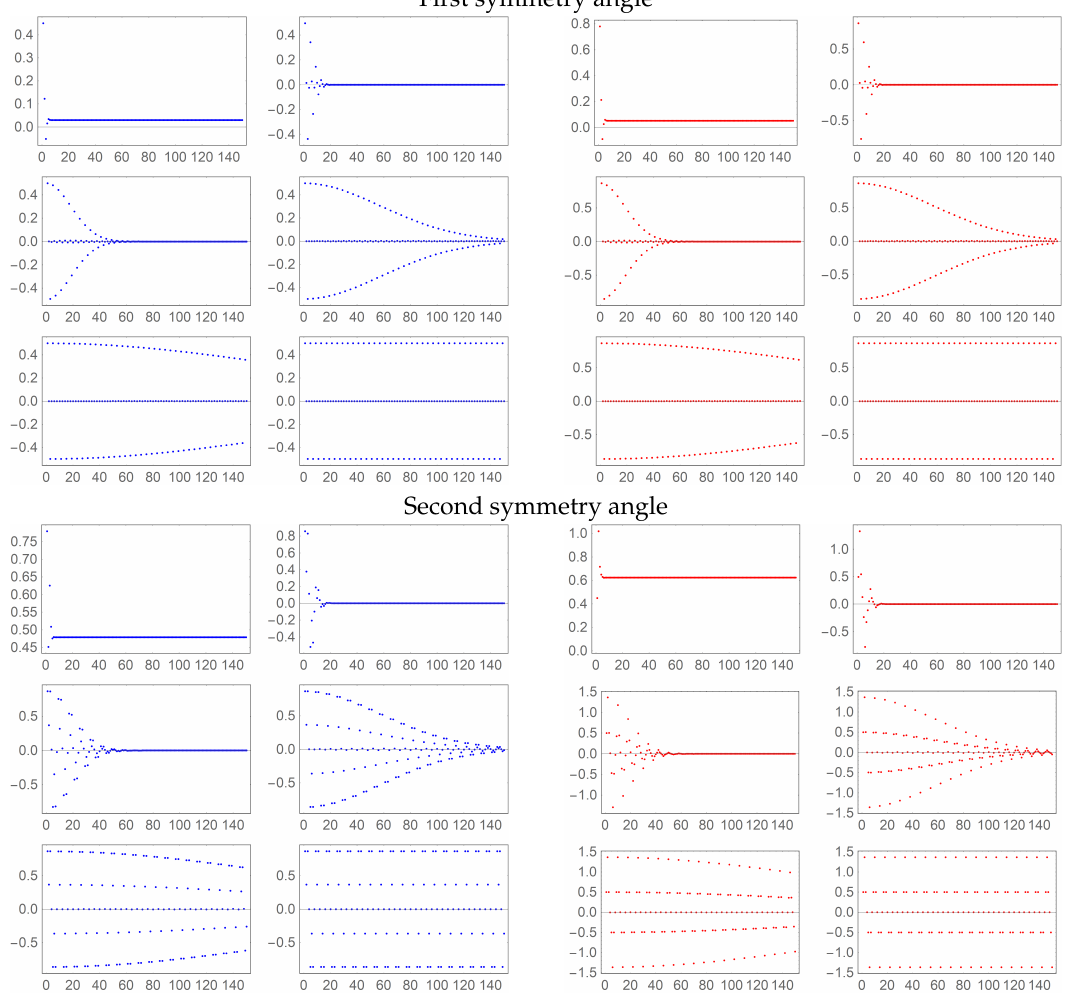
Figure 7. Top set, first symmetry angle: Limit value of L ( C ( 3 ) ; ρ e i π 3 ) (real part, blue; imaginary part, red) at ρ = 0.9,0.99,0.999,0.9999,0.99999,1 as a function of N . Bottom set, second symmetry angle: Limit value of L ( C ( 3 ) ; ρ e i π 6 ) (real part, blue; imaginary part, red) at the same values of ρ as